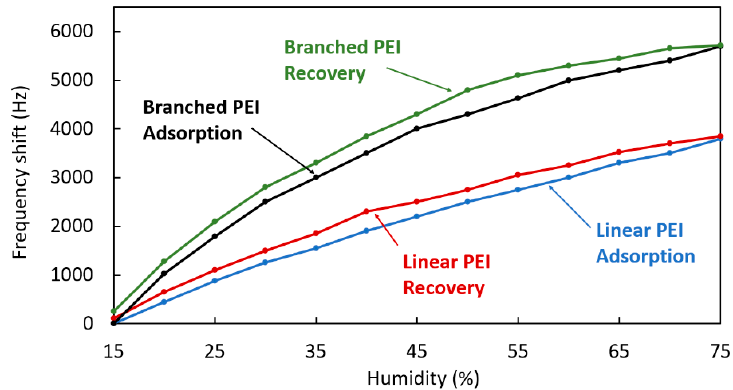
Figure 11. Frequency shift of branched PEI and linear PEI coated crystals at different humidity levels while in absorption and recovery.